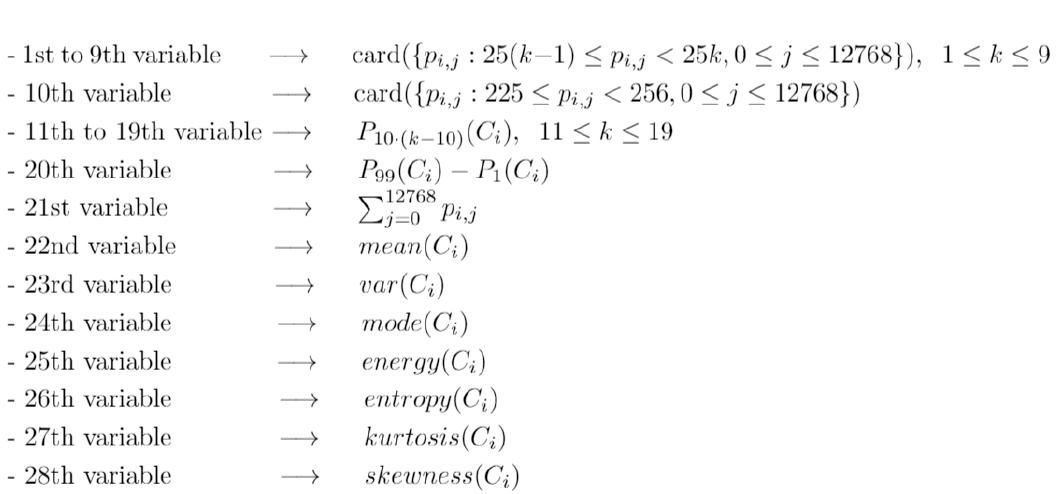
number of pixels between 225 and 255. The next 9 variables represent the 9 percentiles ranging from the tenth percentile to the ninetieth percentile. The last 9 represent the range, tropy, the kurtosis, and the statistical